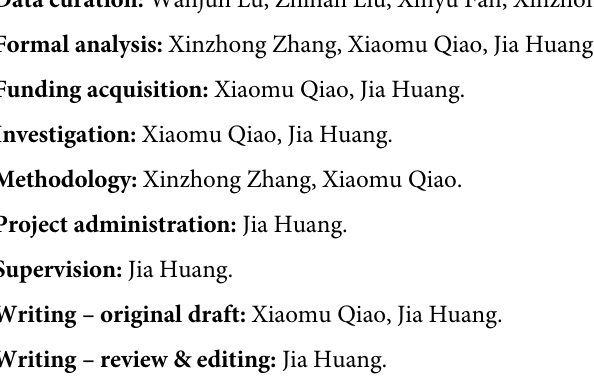
different KO mutants. Fig D in S1 Text. Phylogenetic relationships of core groups of nAChR subunits from 6 representative insect species including Apis mellifera (honey bee), Tribolium castaneum (red flour beetle), Myzus persicae (green peach aphid), Bombyx mori (silk worm), Bombus terrestris (bumble bee) and Drosophila melanogaster (fruit fly). The colorful dots at the nodes of the branches represent the values of bootstrap support for each branch. The D . mela- nogaster FMRFamide receptor (DmFR) was used as an outgroup. The sequence accession numbers are shown in Table N in S1 Text. Table A in S1 Text. Log dose probit mortality data and resistance ratios for imidacloprid. Table B in S1 Text. Log dose probit mortality data and resistance ratios for thiacloprid. Table C in S1 Text. Log dose probit mortality data and resis- tance ratios for acetamiprid. Table D in S1 Text. Log dose probit mortality data and resistance ratios for thiamethoxam. Table E in S1 Text. Log dose probit mortality data and resistance ratios for clothianidin. Table F in S1 Text. dose probit mortality data and resistance ratios for dinotefuran. Table G in S1 Text. Log dose probit mortality data and resistance ratios for niten- pyram. Table H in S1 Text. Log dose probit mortality data and resistance ratios for flupyradi- furone. Table I in S1 Text. Log dose probit mortality data and resistance ratios for sulfoxaflor. Table J in S1 Text. Log dose probit mortality data and resistance ratios for triflumezopyrim. Table K in S1 Text. Log dose probit mortality data and resistance ratios for spinetoram. Table L in S1 Text. Sequence identities between Drosophila nAChR subunits and corresponding orthologs in other insects. Table M in S1 Text. Primers used in qPCR analysis. Table N in S1 Text. The accession numbers of sequences used in Fig D in S1